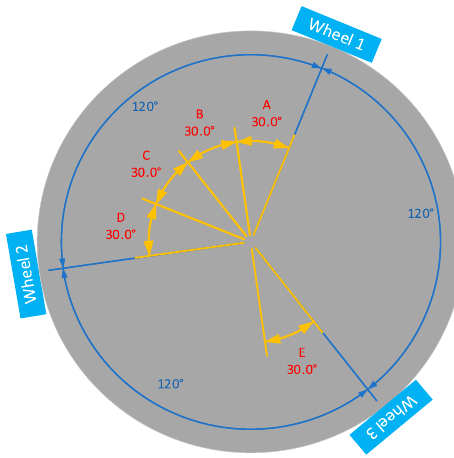
Figure 3. Diagram of TOMR’s angle analysis.